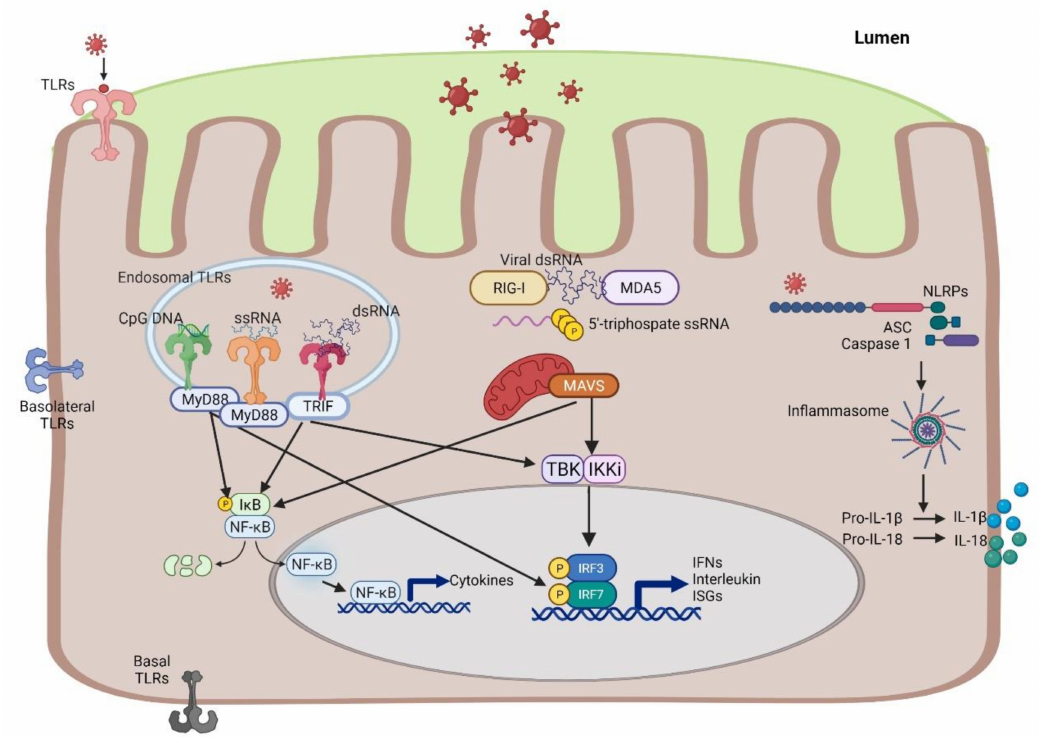
Figure 2. Schematic overview of PRRs involved in the sensing of viral infections in IECs. All TLRs share a common structure and signal through adaptor proteins. The elicited signaling pathway depends on the combination of TLRs and PAMPs. TLR2 and 4 recognize viruses at the cell surface, while TLR3 recognizes double-stranded (ds)RNA and TLR7 and 8 recognize single-stranded (ss)RNA, and TLR9 recognizes DNA with Unmethylated cytosine–guanine dinucleotide (CpG) motifs in the endosomes. Although it is not fully understood why, TLR3, TLR7, and TLR9 may occur both in the cell membrane and intracellularly [47]. TLRs may, in addition to apical and endosomal, include basolateral and basal cell membrane expression. All TLRs, except TLR3, utilize myeloid differentiation factor 88 (MyD88) as an adapter to recruit the signaling pathways leading to the activation of the transcription factors NF-kB, and in some cases interferon regulatory factor (IRF) 7, resulting in the production of pro-inflammatory cytokines and type I IFN. TLR3, on the other hand, utilizes the TIR domain-containing adaptor protein inducing interferon β (TRIF) to activate nuclear factor kappa-light-chain-enhancer of activated B cells (NF-kB) and IRF3 and can trigger the induction of pro-inflammatory cytokines and type I interferon β . The cytosolic receptors retinoic acid-inducible gene I (RIG-I) and melanoma differentiation-associated gene 5 (MDA5) detect viral-mediated dsRNA or ssRNA structures, respectively. They signal through the adaptor protein mitochondrial antiviral signaling (MAVS), eventually activating NF-kB or IRF3. NLRs are cytosolic PRR sensors that upon the recognition of PAMPs or DAMPs oligomerize into large macromolecular scaffolds called inflammasomes, which promote the maturation and secretion of interleukin (IL)-1 β and IL-18. Illustration created by MDH using Biorender.com. https://biorender.com/ (accessed 30 August